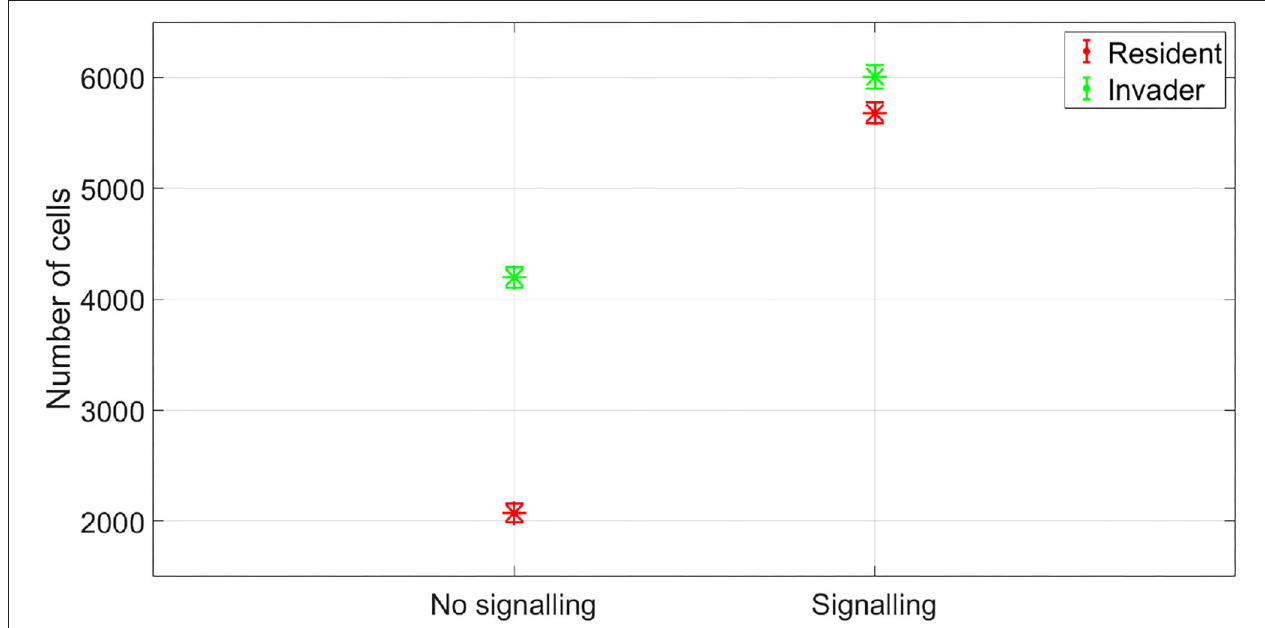
FIGURE 8 | The fitness of the two species in no antibiotic signaling scenario vs. signaling scenario. In the signaling scenario, both the invader and the resident species benefit from the evolution of a signaling mechanism. The data representation is the same as Figure 4 .